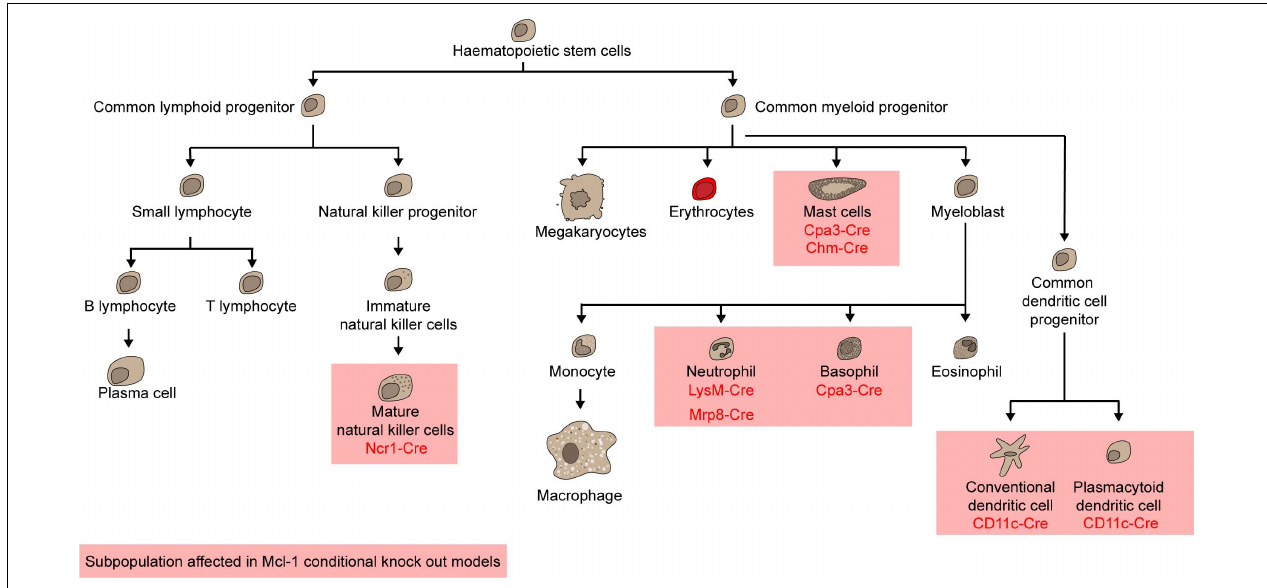
FIGURE 5 | Mcl-1 is indispensable for mature natural killer cells, mast cells, neutrophils, basophils, conventional dendritic cells, and plasmacytoid dendritic cells.